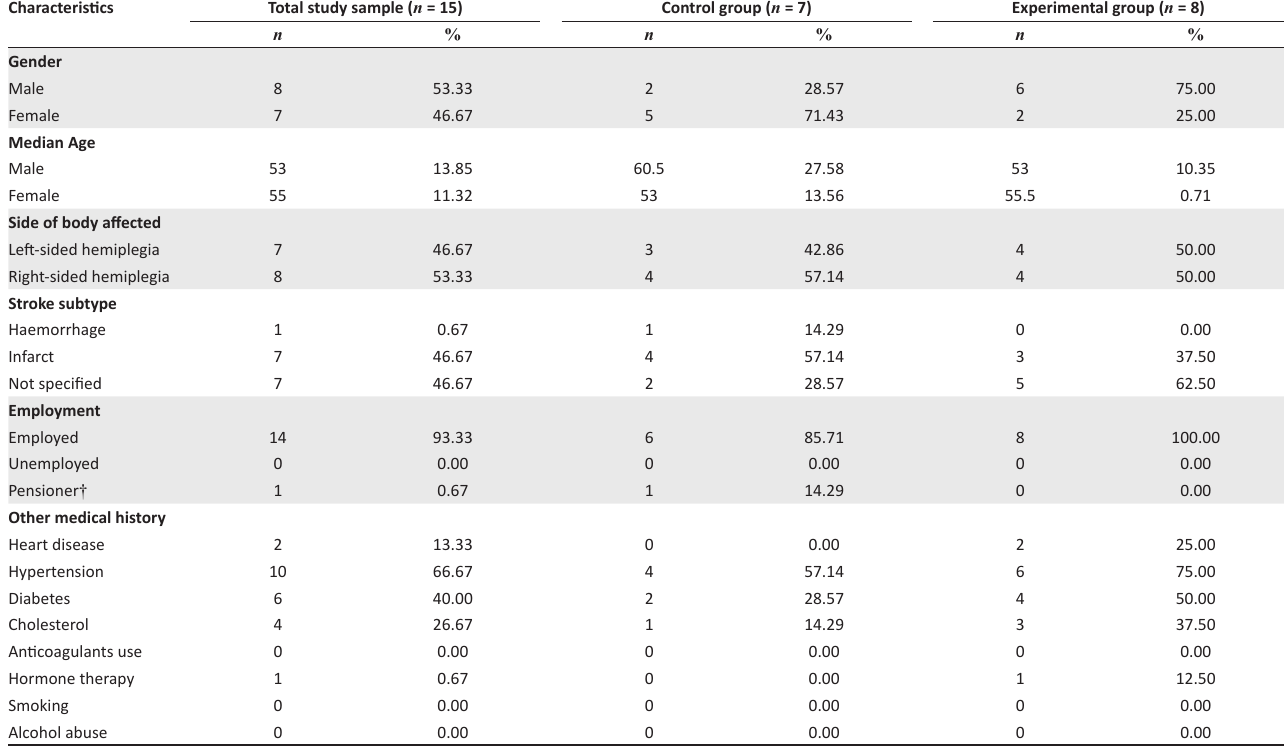
TABLE 2: Socio-demographic and clinical characteristics of the study sample ( n = 15).